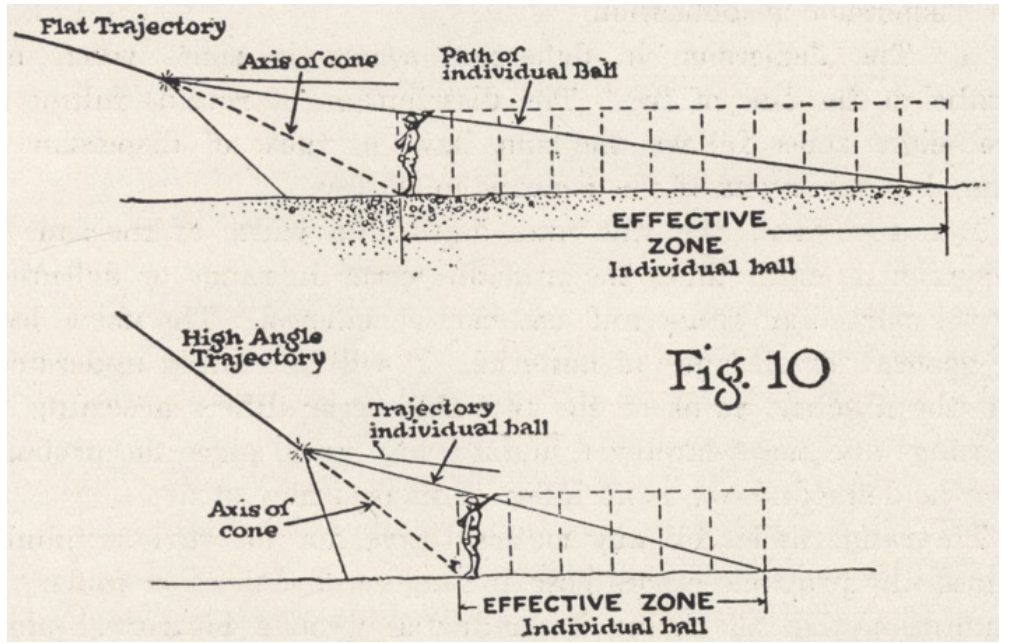
Fig. 6 Beard C., Fire and